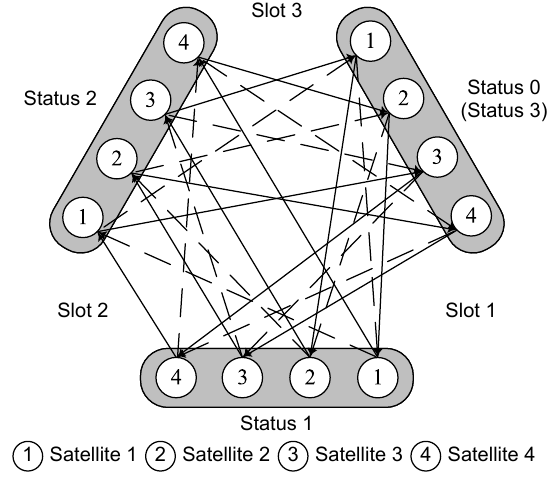
Fig. 4 Status loop of a four-satellite